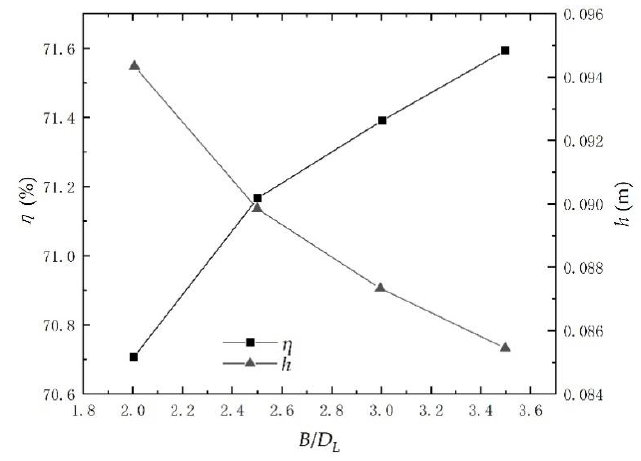
Figure 13. Pump system efficiency and hydraulic loss curve with different width.